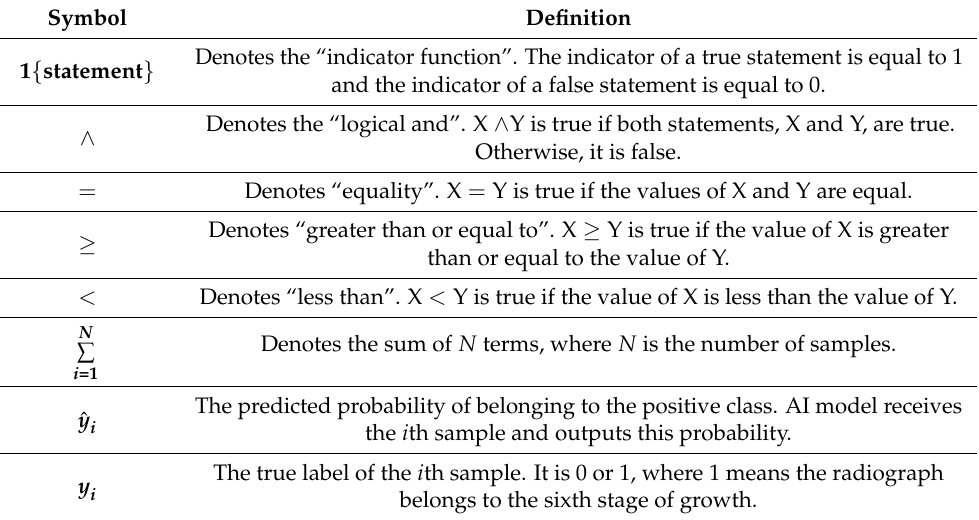
Table 2. Mathematical symbols and